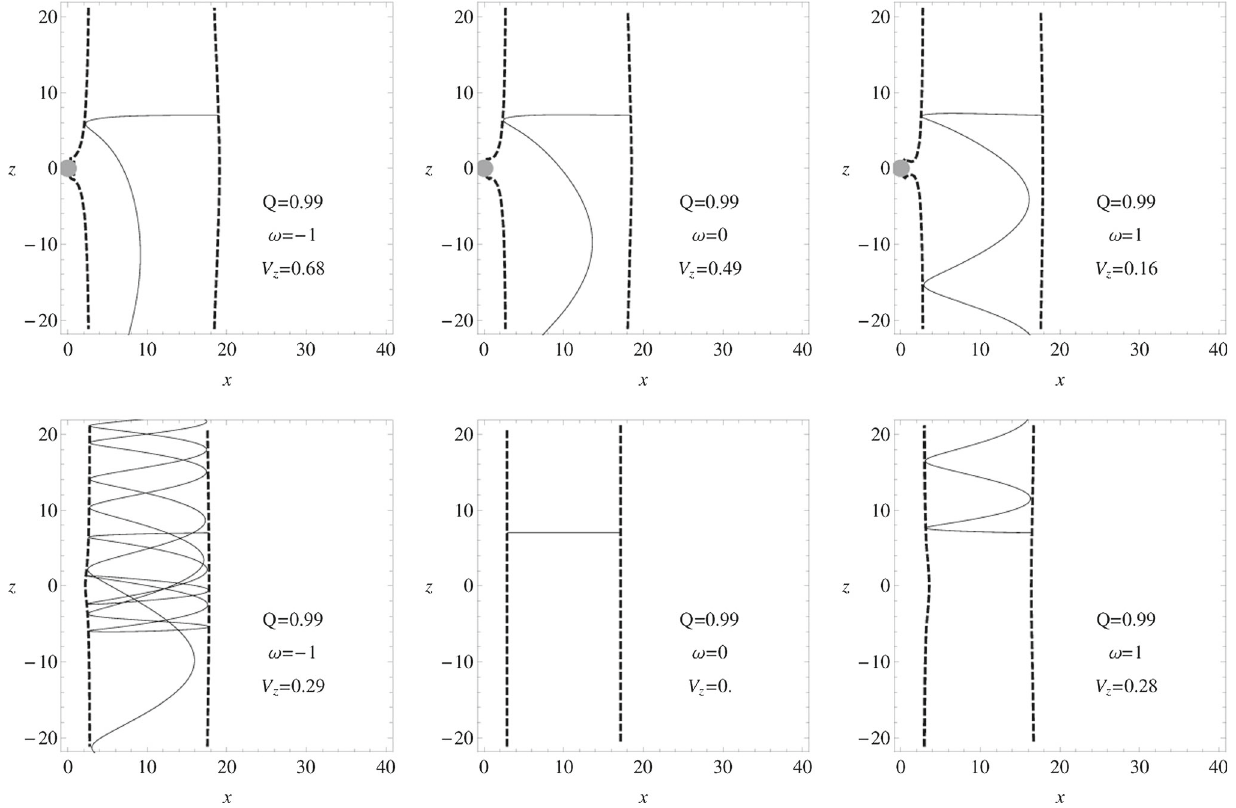
Fig. 12 Escaping trajectories of string loop in RN(top line elements) and flat spacetime(bottom line elements). Asymptotical speed of trans- mitted string loops given for three values of ω parameter for charged black hole Q and flat spacetime. The asymptotical ejection speed of